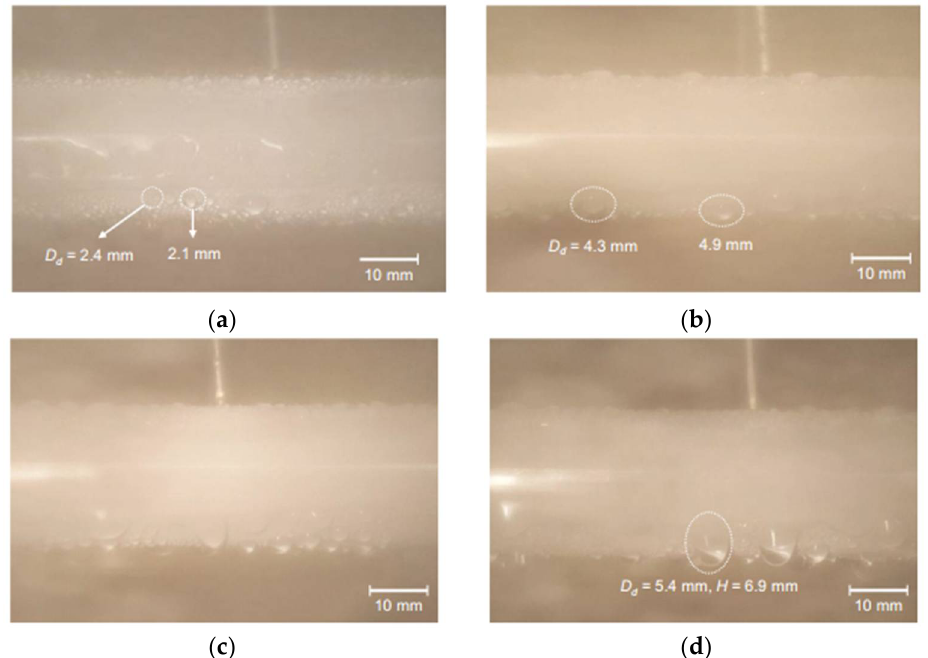
Figure 27. Condensation phenomena. ( a ) Dropwise condensation phenomenon. ( b ) Flooded con- densation phenomena (departing frequency: 19.6 drops/min). ( c ) Flooded condensation phenomena (departing frequency: 19.6 drops/min). ( d ) Attached condensation phenomena (departing fre- quency: 8.1 drops/min). Reprinted with permission from Ref [124]. Copyright 2019 Elsevier.